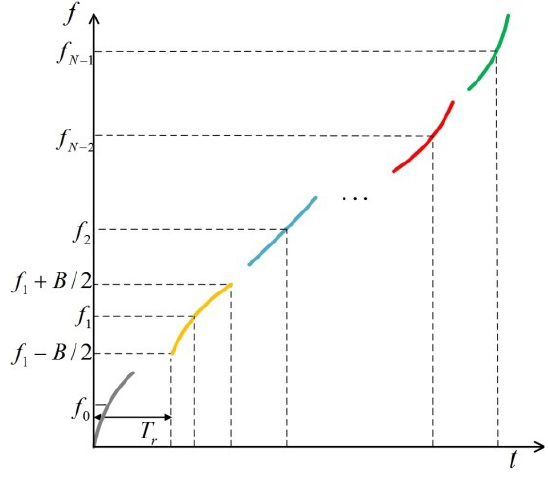
Figure 2. SF FM subpulse Model.